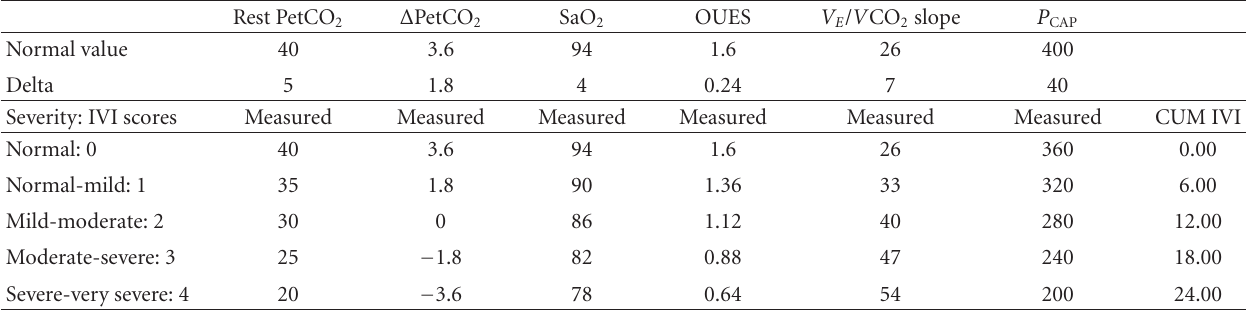
Table 1: Model showing individual variables (individual variable index, IVI) that make up the multivariable scoring system. Normal values from literature with delta representing a risk cuto ff for each IVI. (MVI = CUM